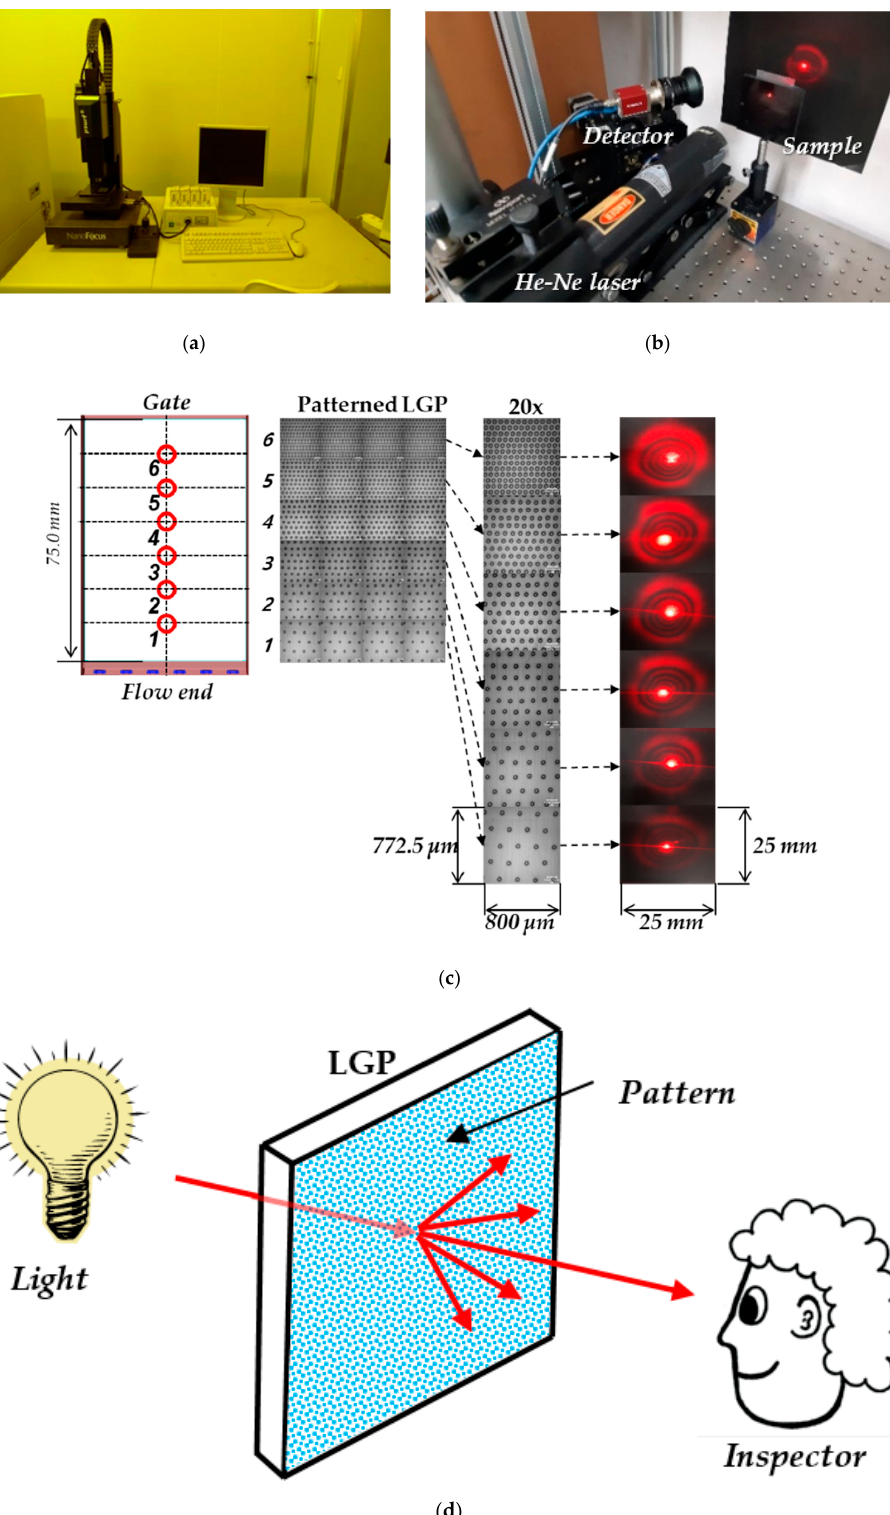
Figure 11. ( a ) A photograph of µ-surf (Nanofocus, Inc.). ( b ) Vision equipment for measuring scattering and diffraction patterns. ( c ) Micropattern on LGP surface and scattering image. ( d ) Conceptual set-up for industrial inspection system of injection-molded LGPs.